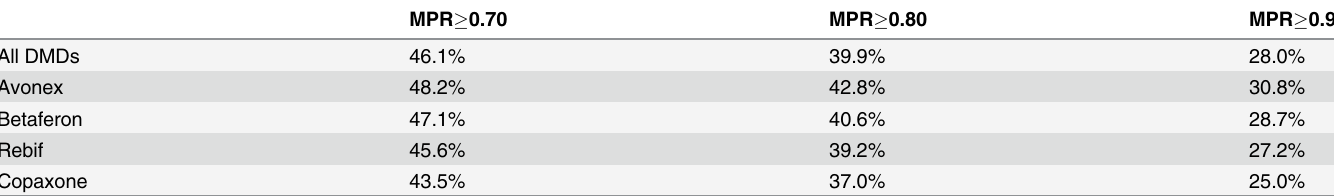
Table 2. Sensitivity analysis (S1): Proportion of profiles of compliant patients for three different thresholds of MPR.